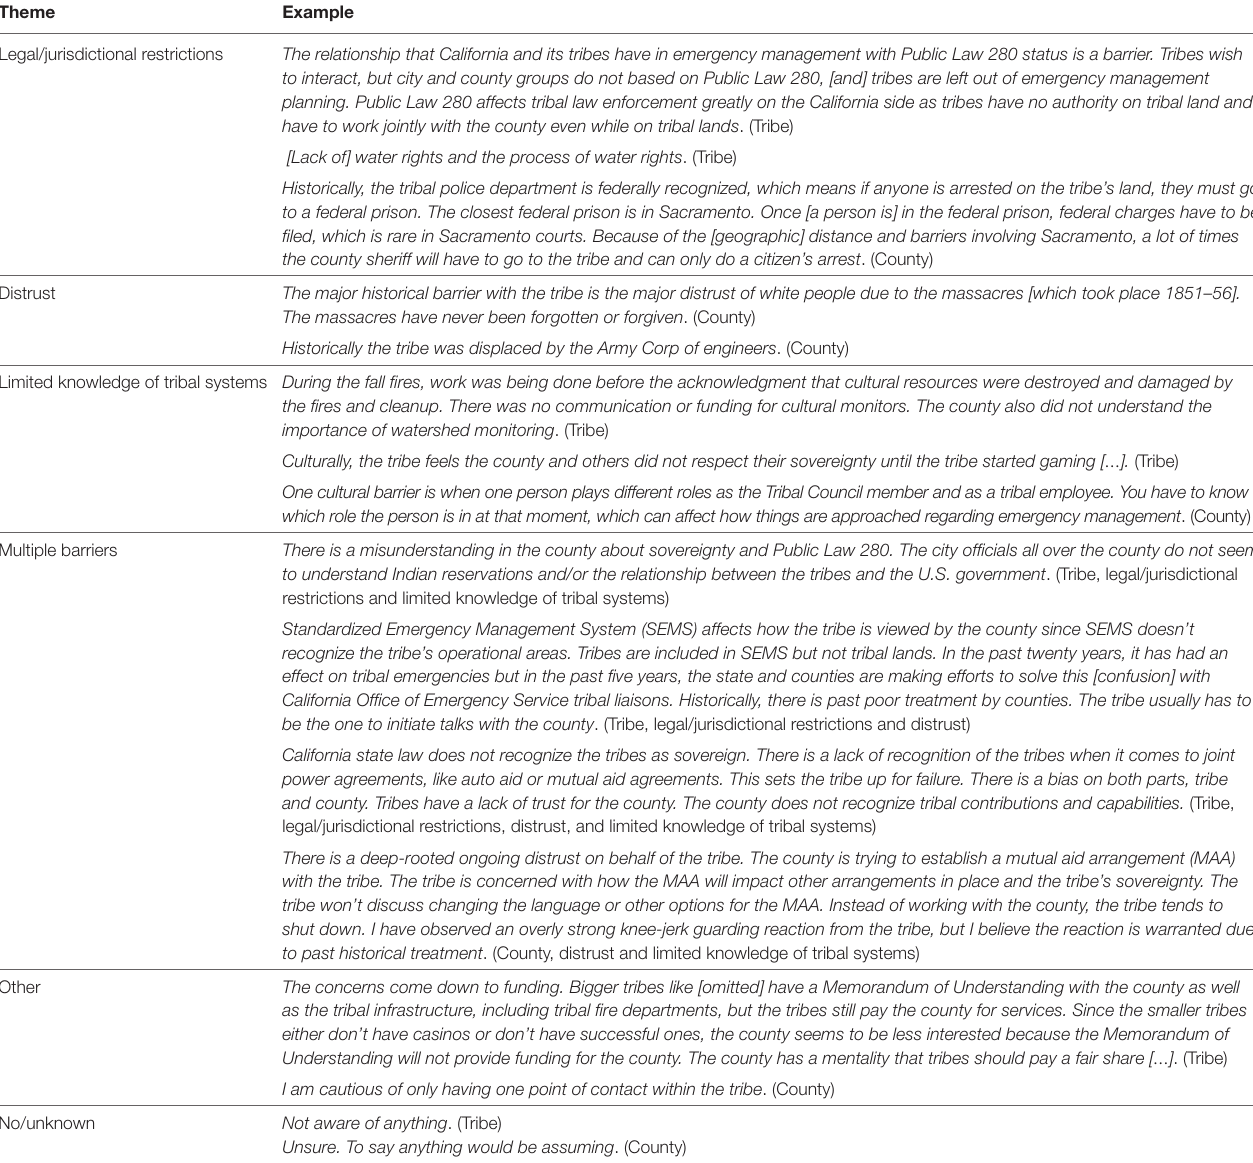
Table 4 | Examples of tribe- and county-reported barriers to CJS by theme.